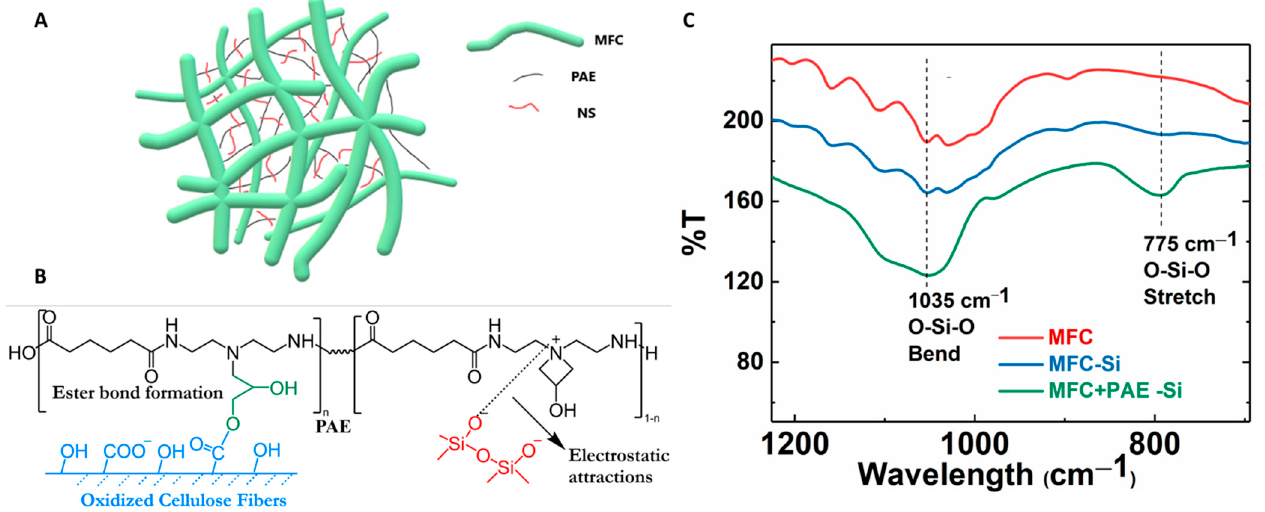
Figure 9. ( A ) The possible mechanism of silica NPs bridging between MFC nanofibers. ( B ) Illustration of the covalent bonding formed between the carboxylate group on MFC and the azetidinium group on PAE, as well as the electrostatic interaction between silica NPs and PAE. ( C ) FTIR analysis of MFC, MFC-NS (without PAE), and MFC-NS (with PAE) membranes.